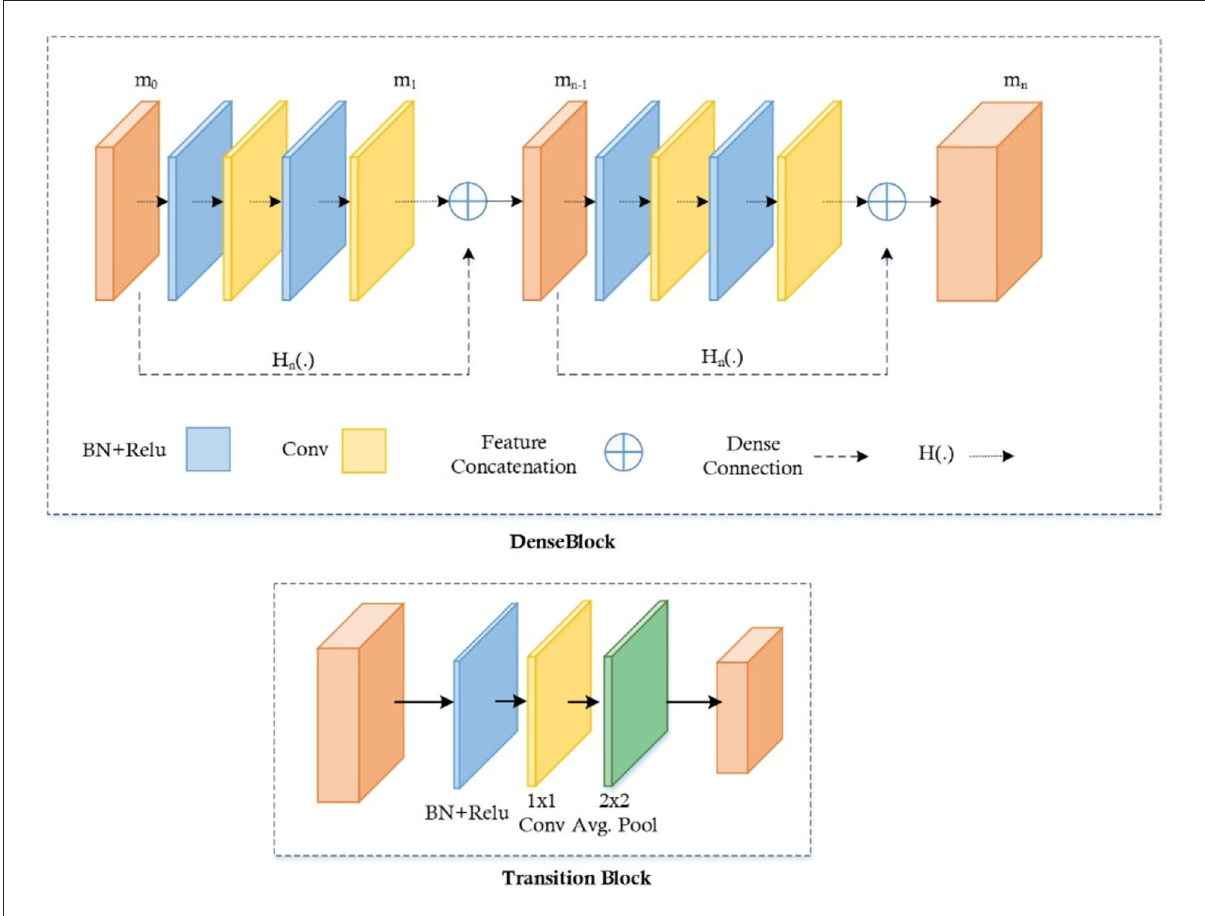
FIGURE3 Dense block and transition